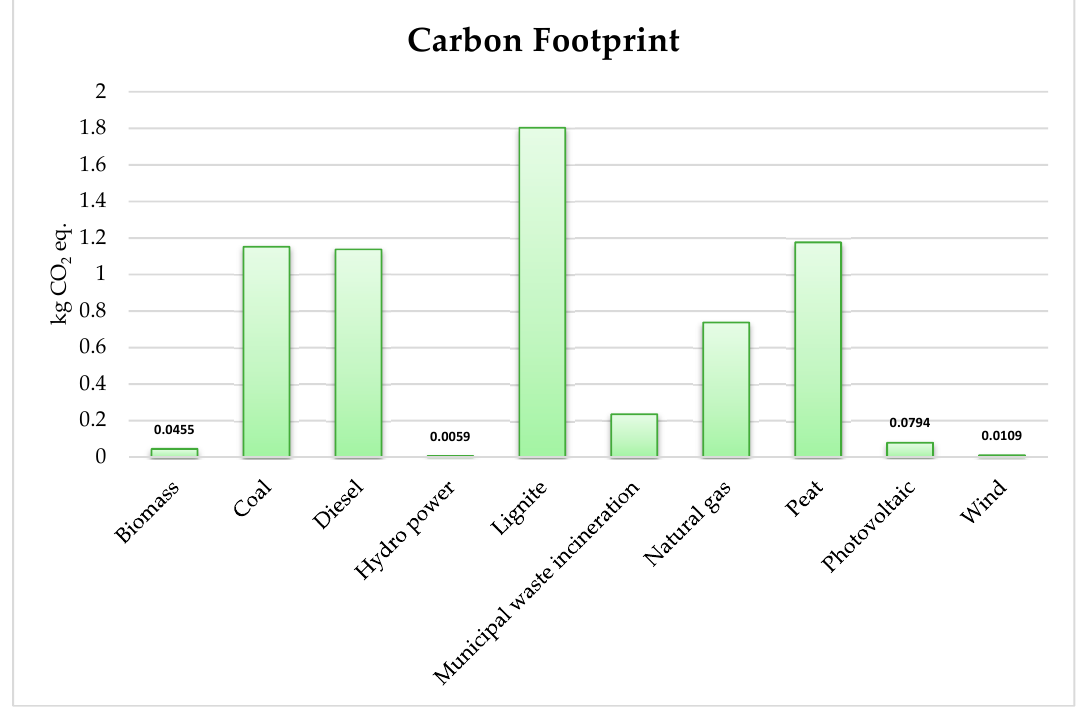
Figure 2. Carbon footprint results for human health, calculated according to the IPPC guideline.